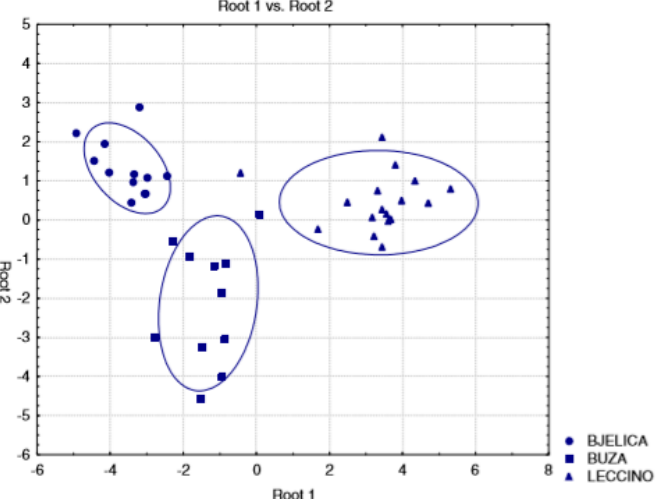
Figure 3. Discriminant analysis—scatterplot of canonical scores (range, coefficient 0.95). Reference [11] with permission from Elsevier.